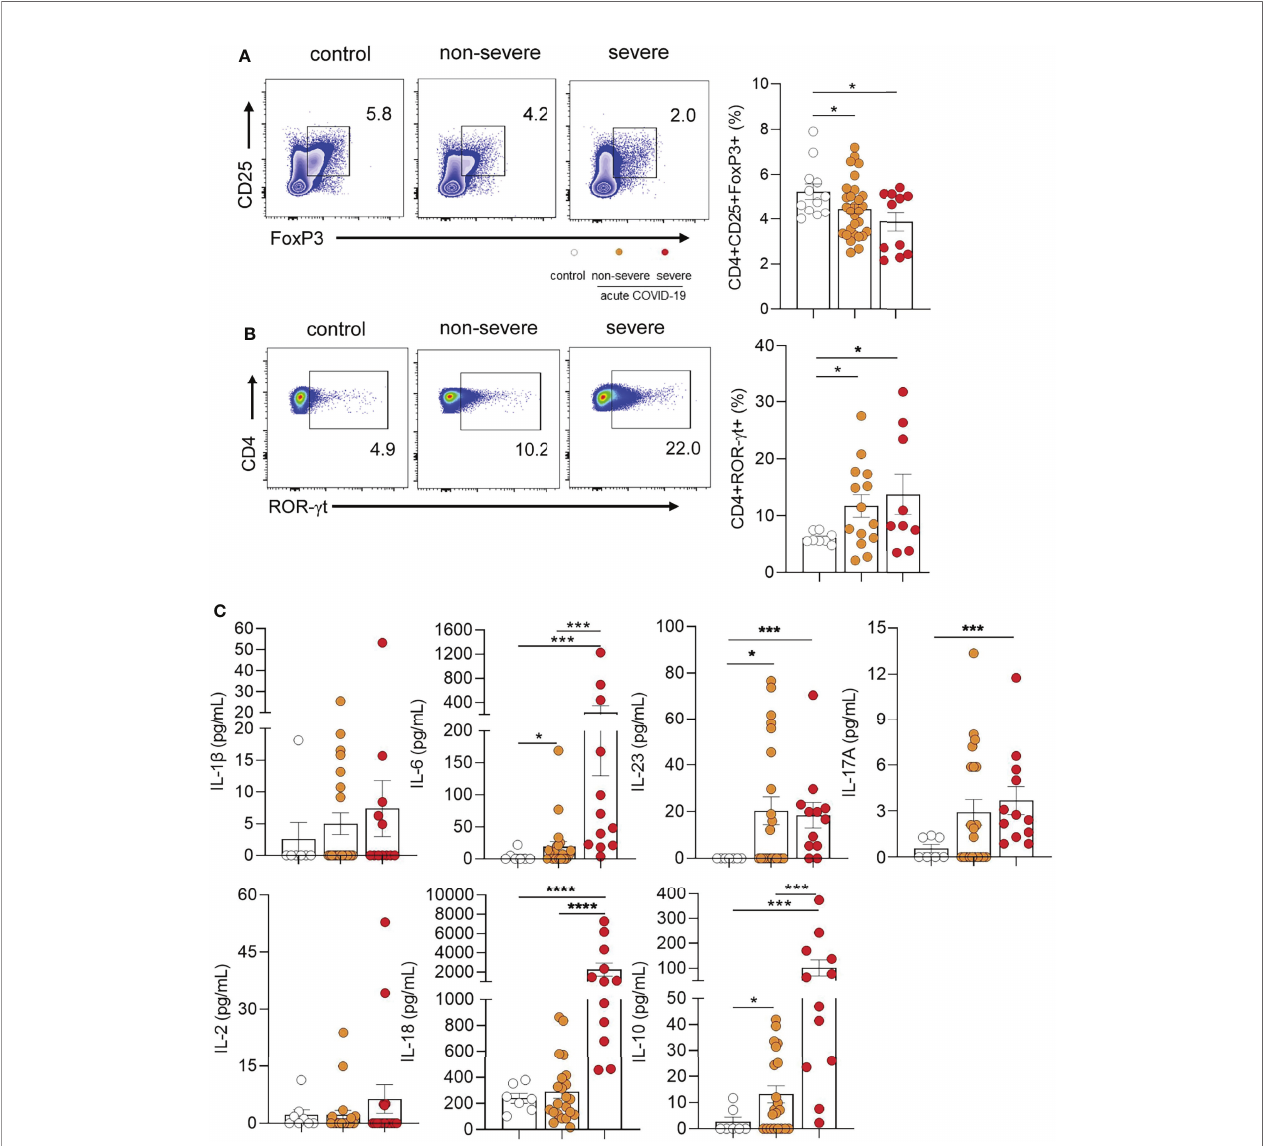
FIGURE 1 | Frequency of Tregs and TH17 cells in children with COVID-19. (A) Left panel: Representative dot plot showing the expression of FoxP3 and CD25 in CD4+ T cells. Tregs were de fi ned as CD4+CD25+FoxP3+. Right panel: Frequency of Tregs in controls (n = 12) and children with non-severe (n = 29) and severe (n = 11) COVID-19 analyzed by fl ow cytometry. (B) Left panel: Representative dot plot showing the expression of ROR- g t in CD4+ T cells. Right panel: Frequency of CD4+ROR- g t+ T cells in healthy children (controls, n = 8), and children with COVID-19 (non-severe, n = 14 and severe, n = 9). (C) Plasma levels of IL-1 b , IL-6, IL-23, IL-17A, IL-2, IL-18 and IL-10 were quanti fi ed by multiplex fl ow cytometric bead array in healthy children (controls, n = 7), and children with COVID-19 (non-severe, n = 22 and severe, n = 12). Data are expressed as the percentage of CD4+ T cells in (A) (right) and (B) (right). Mean ± SEM of n donors are shown in (A) (right), (B) (right) and (C) P values were determined by Mann-Whitney U test, Kruskal-Wallis test and Wilcoxon test: *p < 0.05, ***p < 0.001, ****p <